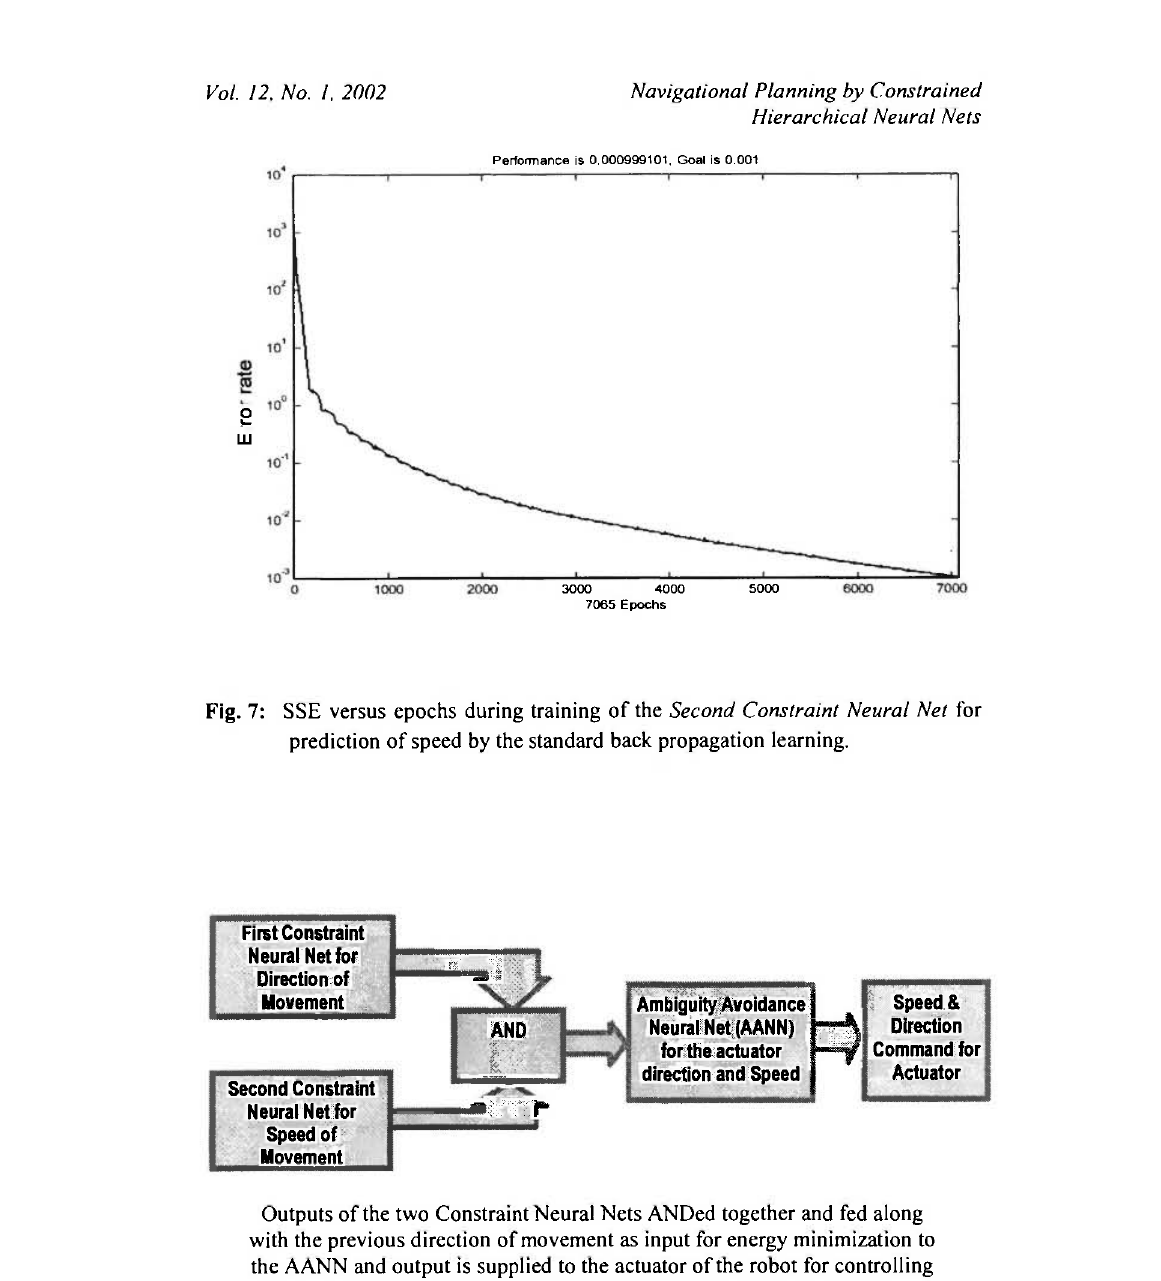
Fig. 8: Outputs of the two Neural nets (Direction and Speed) are ANDed